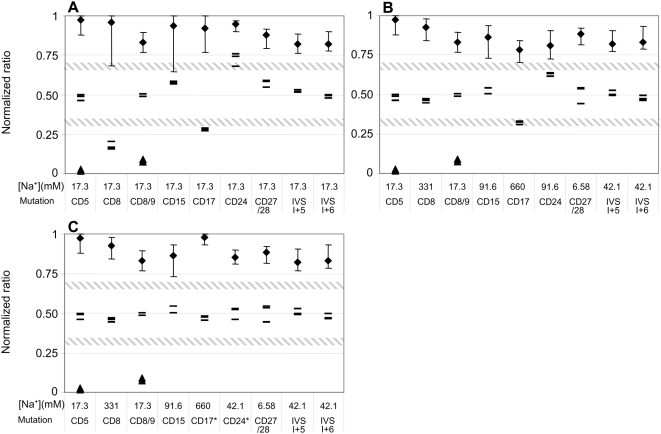
Comparison of different methods of genotyping in the MSAW.We defined probe pair performance as successful when homozygotes had normalized ratios of >0.7 (wild types) or <0.3 (mutants), and heterozygotes had normalized ratios between 0.35 and 0.65; these limits are indicated by the hatched lines in the graphs. (A) T
m-matched probe set in which all probes were washed under the single optimal condition of 17.3 mM sodium. (B) T
m-matched probe set in which each probe pair was washed at its individual optimal sodium concentration, so that the normalized ratio of the heterozygotes was as close to 0.5 as possible, and the separation into genetic classes was as good as could be achieved. (C). A mixed set of probe pairs, all of which originated from the Tm-matched probe set, except those specific for positions CD17 and CD24, for which we substituted shorter probes (indicatd by asterisks) (see also Table 1). The ratio shown for each probe pair represents the condition that was optimal for clear classification of genotypes, which is indicated by the values given below each mutation. Computation of normalized ratios is explained in the Materials and Methods section, and the symbols used are described in the legend of Figure 4.